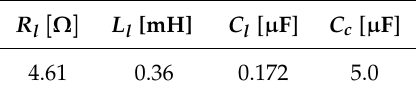
Table 2. System parameters for the stability simulations.